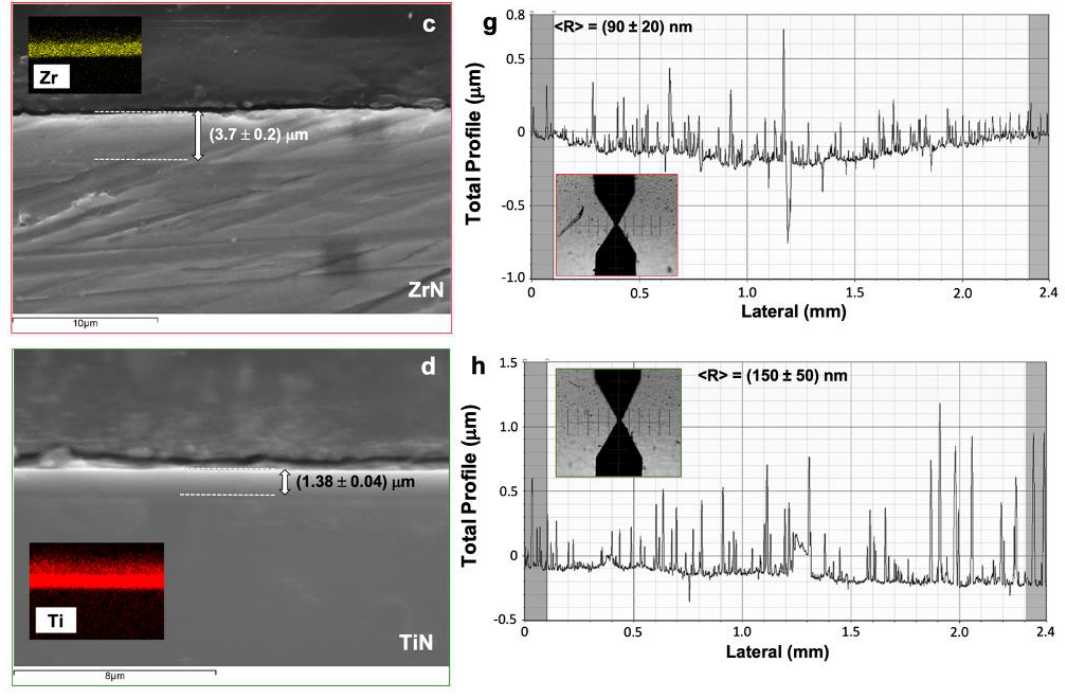
Figure 1. SEM micrographs and profilometry maps of ( a , e ) AlTiN, ( b , f ) NbN, ( c , g ) ZrN and ( d , h ) TiN. Insets: ( a – e ) EDX maps and coatings thickness; ( f – l ) optical micrographs and roughness values.